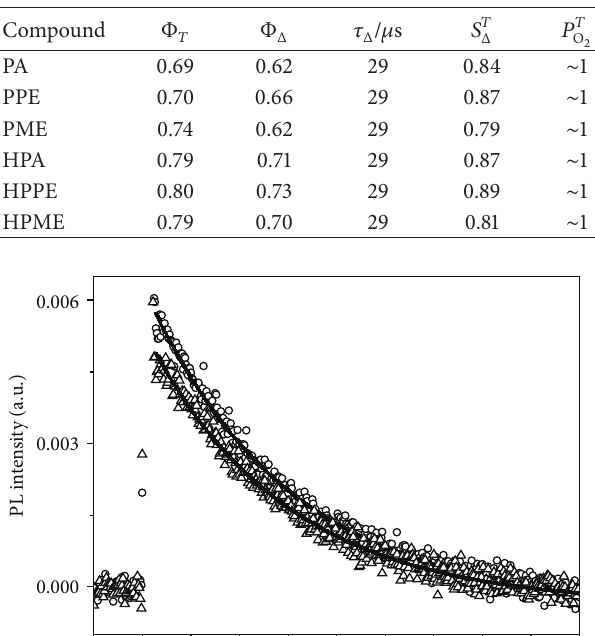
Figure 4: Time-resolved 1 O 2 phosphorescence signals ( 𝜆 507 nm) and the fitted lines of PA (o) and HPA ( 󳵻 ) in toluene